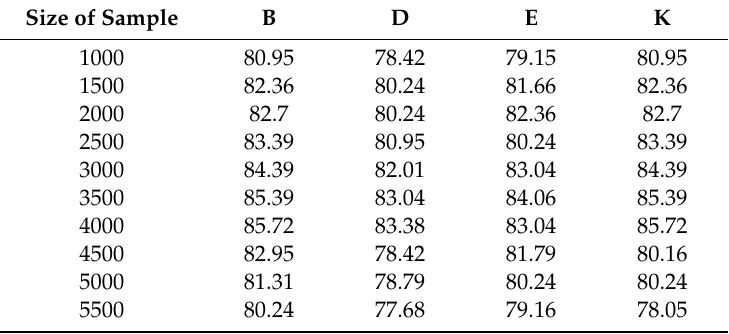
Table 4. Results (F-Measure) of Integrated Model with di ff erent sizes of selected